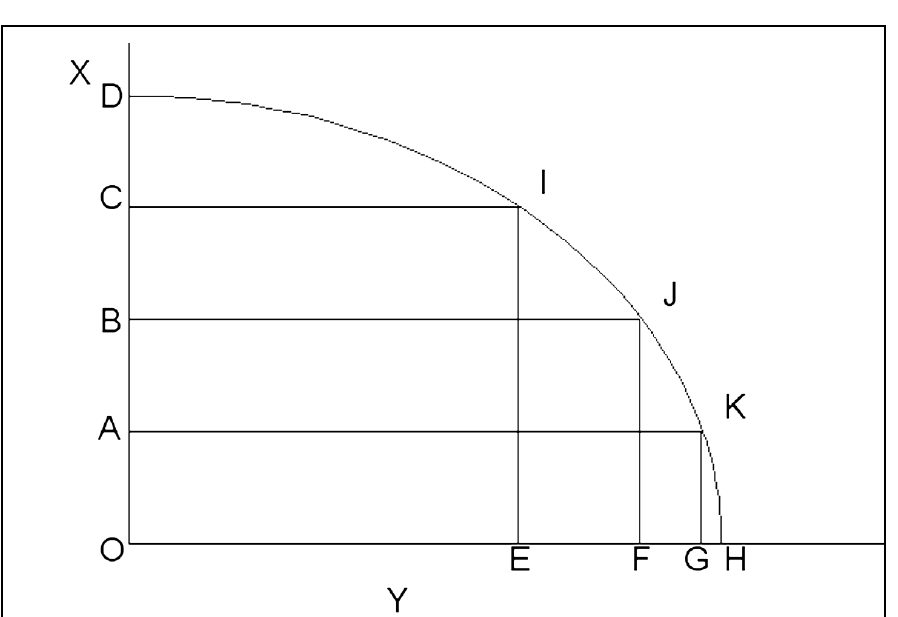
Figure1. A production possibility